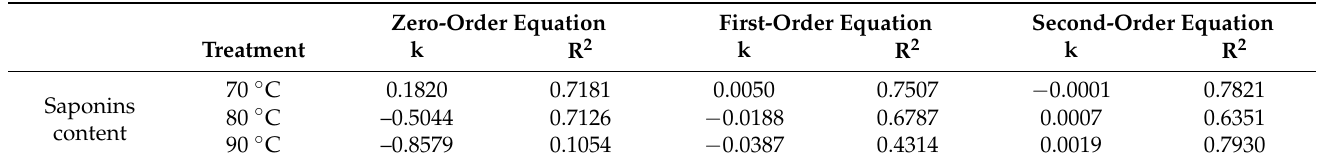
Table 2. Saponins value of k and R 2 for zero-, first-, and second-order reactions during thermal processing of